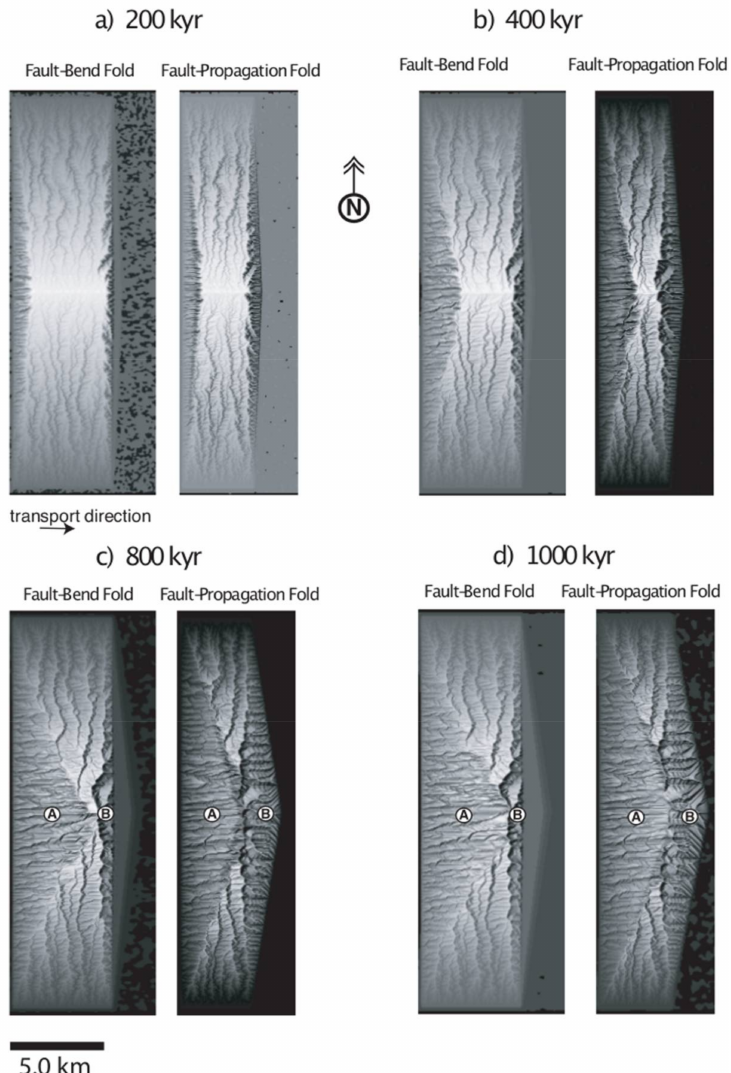
Figure 10. Evolution of the fault-propagation and fault-bend fold models under conditions of instantaneous lateral propagation and linear slip distribution. ( a ) 200 kyr, ( b ) 400 kyr, ( c ) 800 kyr and ( d ) 1000 kyr. Greyscale shaded relief images with illumination from NW, azimuth is 30 degrees. A and B are drainage basins discussed in